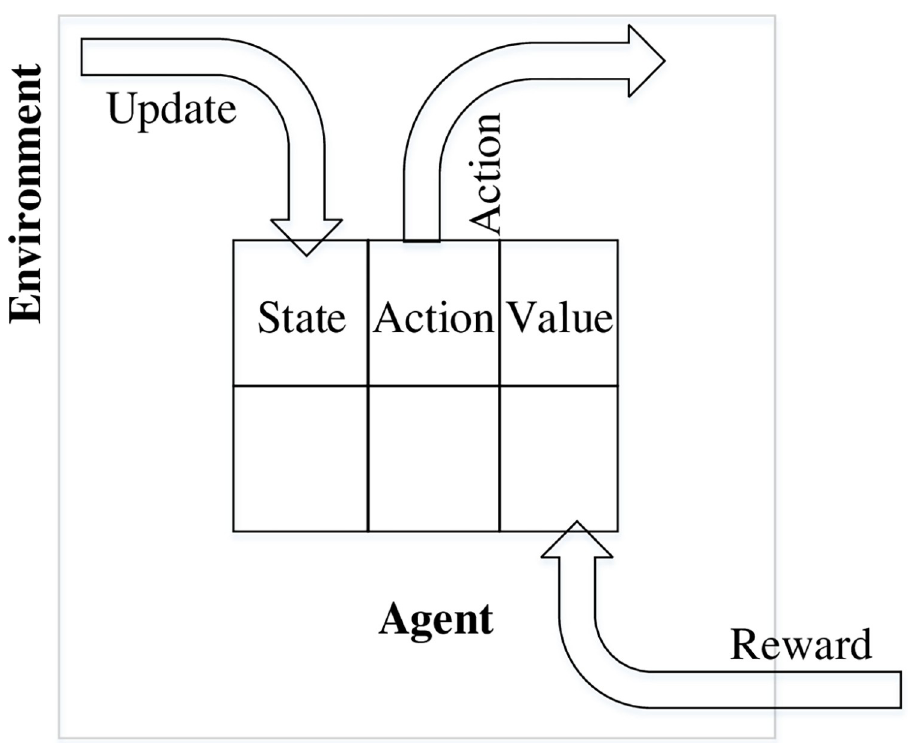
Fig 2. Interaction models for reinforcement